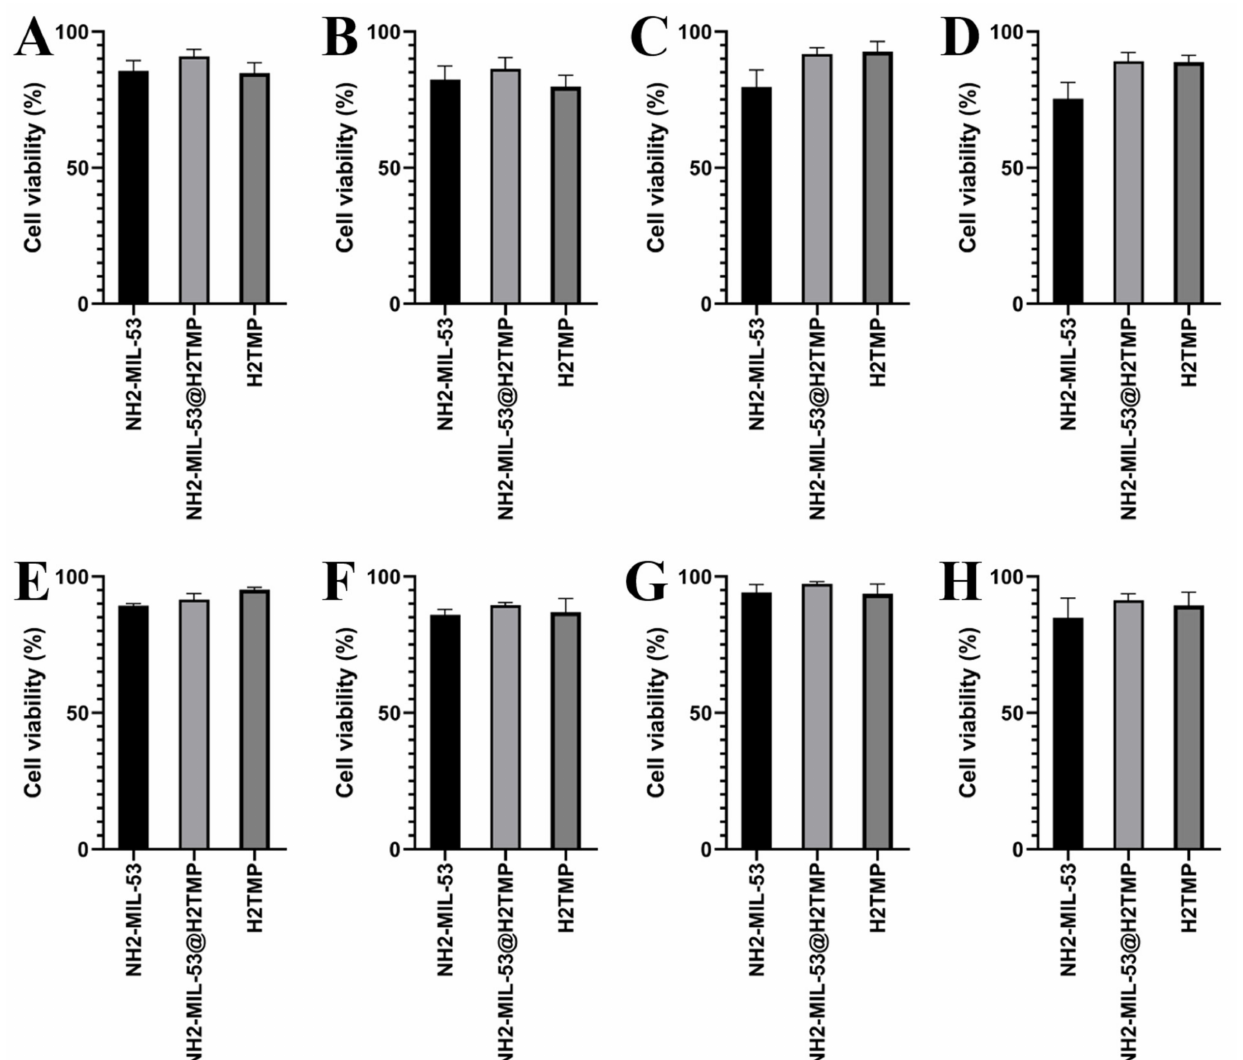
Figure 4. MTT results (with the median values) of the synthesized nanomaterials on the HEK-293 ( A , B ), HeLa ( C , D ), HepG2 ( E , F ), and PC12 ( G , H ) after (24 and 48) hours of treatment, respectively. The data shown here are represented by the median values, and the exact concentrations appear in Figure